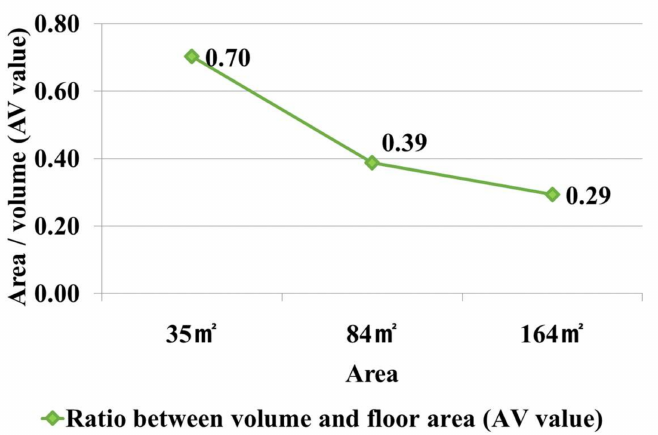
Figure 13. Ratio between volume and elevation area (AV